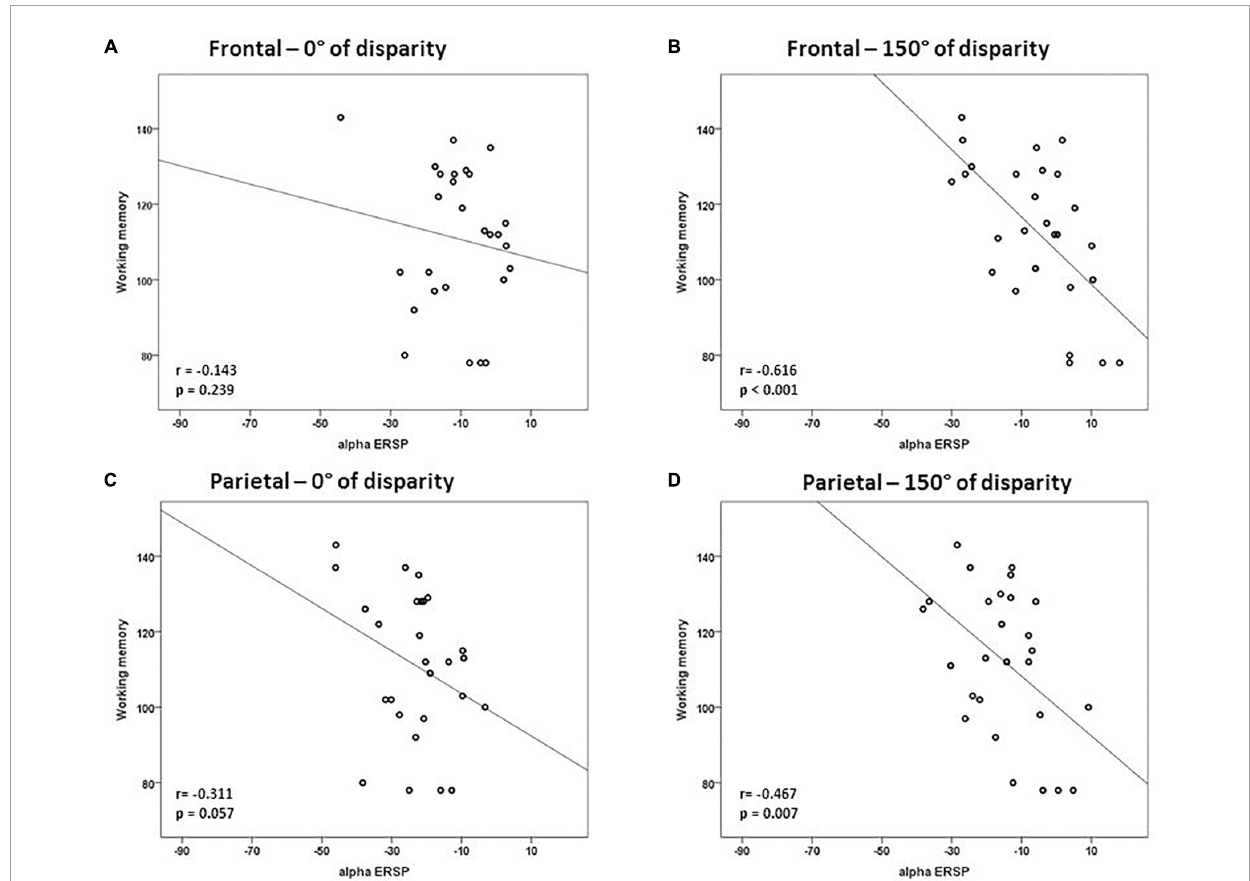
FIGURE3 Correlations between intelligence scores and alpha event-related spectral perturbation (ERSP) in frontal and parietal regions of interest. There was a strong correlation between working memory scores and alpha ERSP values recorded over the frontal ROI during trials of 150 ◦ of disparity (B) . Correlations of easy trials of 0 ◦ of disparity are in panels (A,C) , and of difficult trials of 150 ◦ are in panels (B,D) . Values are in µ